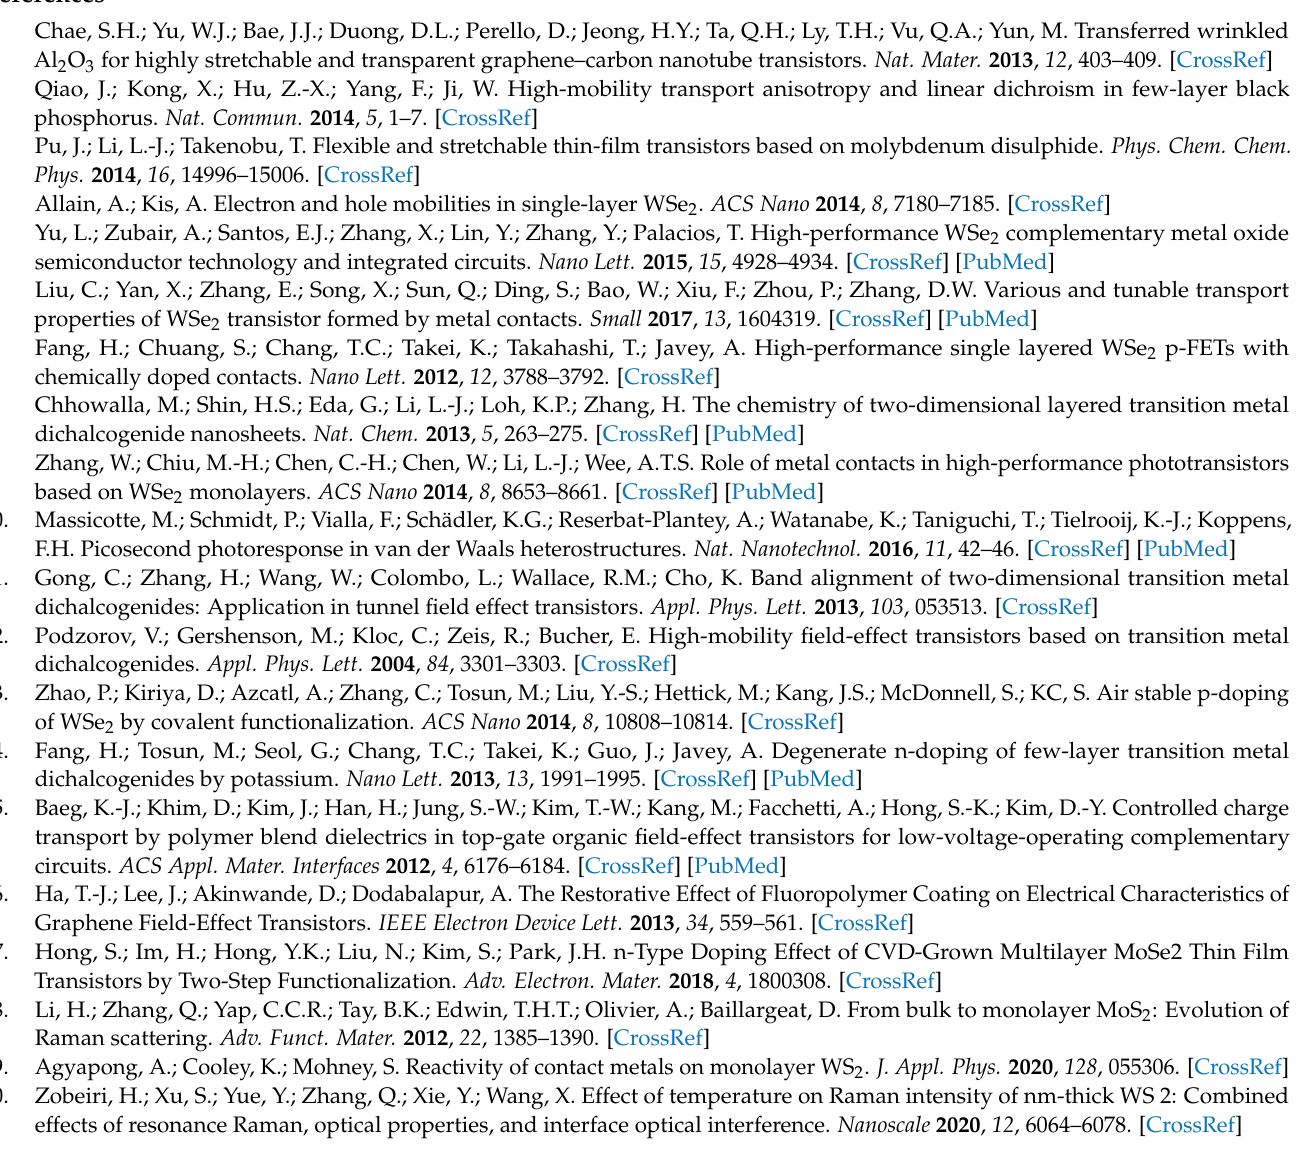
(b) pristine WSe 2 ( T A = 500 ◦ C), (c) F-WSe 2 ( T A = 500 ◦ C), respectively. Table S1: Comparison of electrical characteristics of high-performance WSe 2 devices. Table S2: Raman shift comparison for TMD